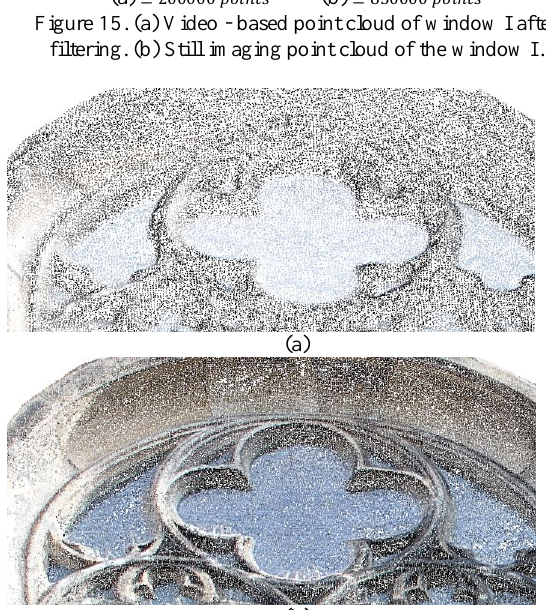
Figure 16. (a) Point cloud from video imaging. (b) Point cloud from HR still imaging.